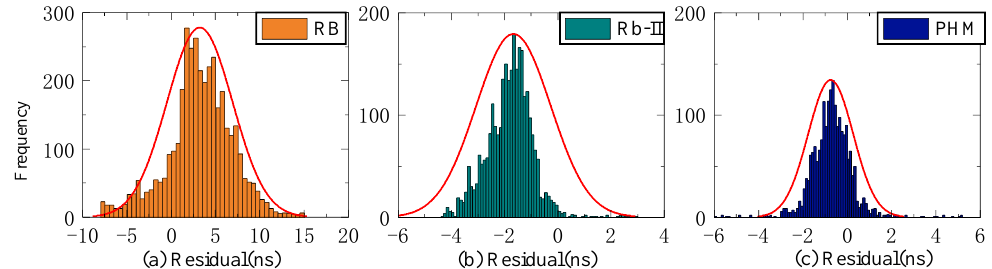
Figure 6. The ISUP-ISC residuals of three atomic clocks. ( a ) The residual distribution of the RB clock. Sensors 2023 , 23 , x FOR PEER REVIEW ( b ) The residual distribution of the Rb-II clock. ( c ) The residual distribution of the PHM clock.